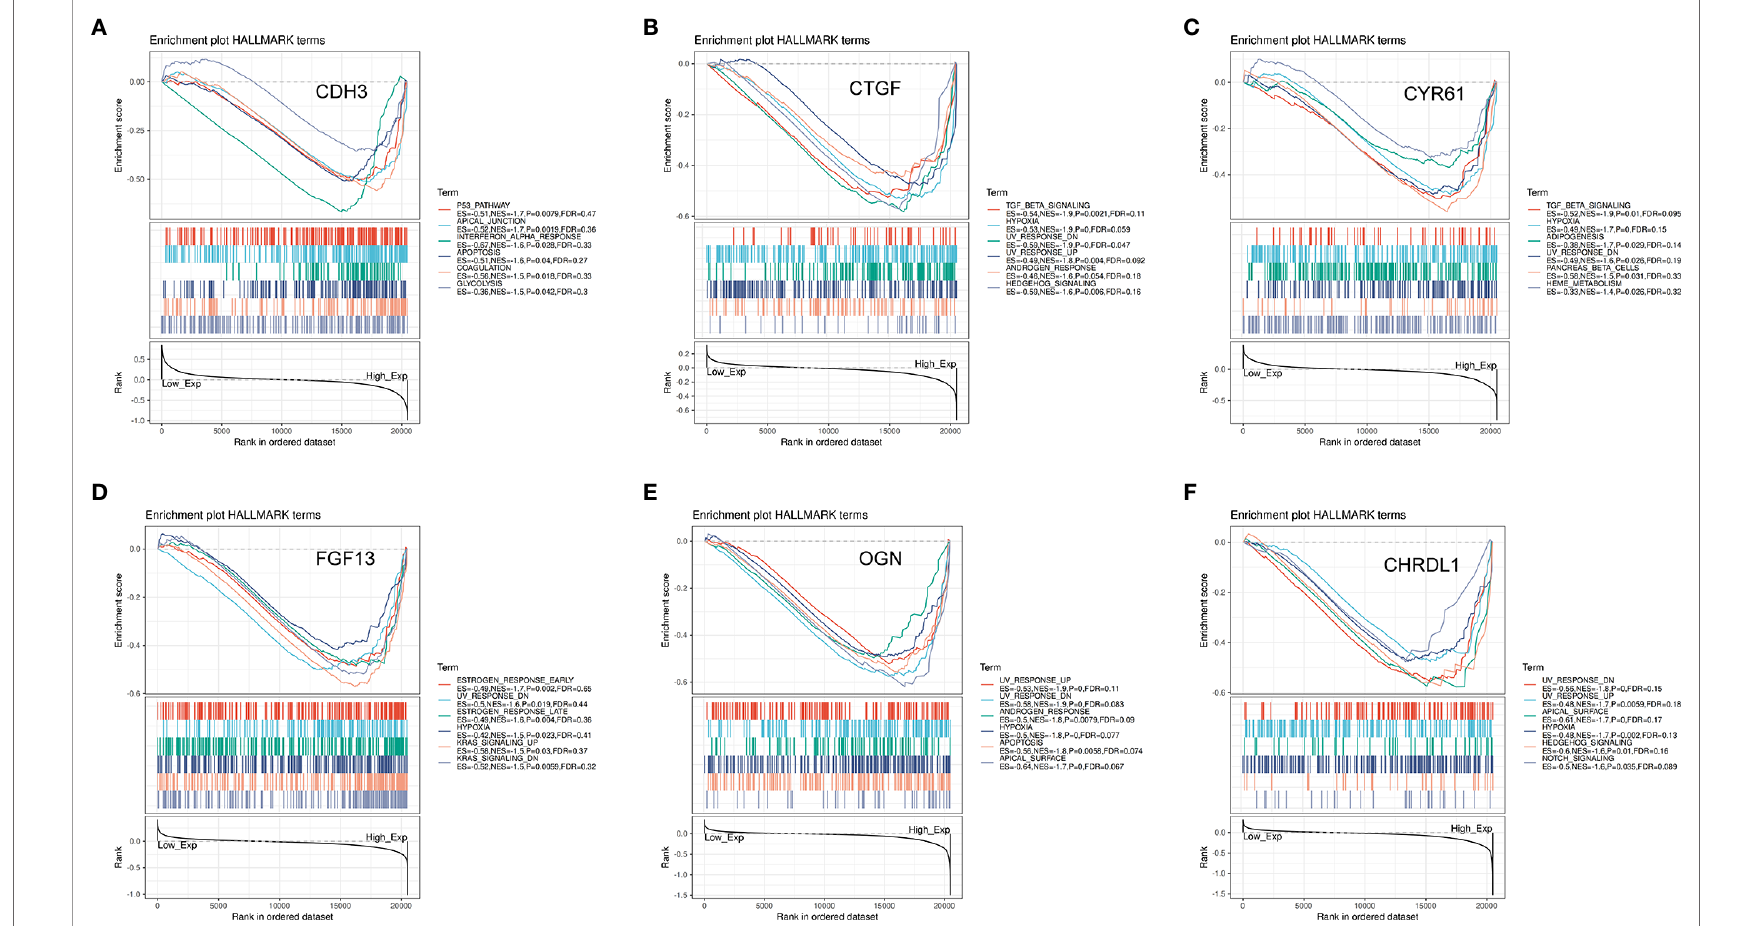
FIGURE 14 | Signi fi cant genes associated with six hub genes and hallmark pathways in THCA obtained by GSEA. (A – F) Top six gene sets according to a GSEA enrichment score for CDH3, CTGF, CYR61, FGF13, OGN , and CHRDL1